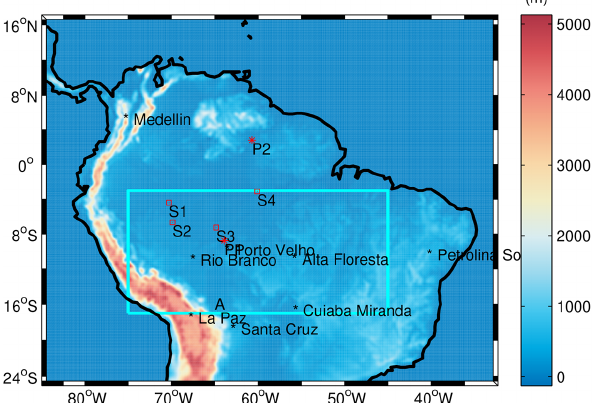
Figure 1. Model domain and orography. Box A (blue) is used to calculate the short-range weather changes due to BBA in Table 2. S1, S2, S3 and S4 show locations of surface observations at Ben- jamin Constant, Eirunepe, Labrea and Manaus respectively. P1 and P2 are locations of radiosoundings at Porto Velho and Boa Vista. Asterisks (*) denote AERONET stations.